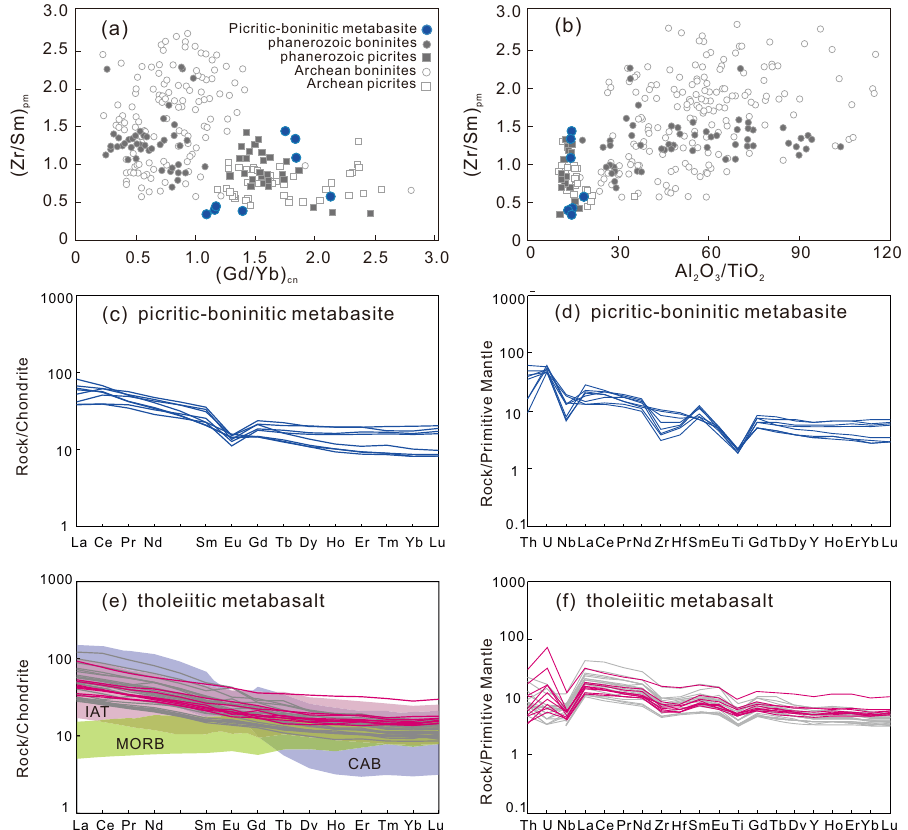
Fig. 7 Multi-element discriminant plots and variation diagrams of picritic-boninitic-tholeiitic series rocks. a , b Variation diagrams for a global dataset of Archean and Phanerozoic picrites and boninites 9 with our samples (blue) falling within the range for most elements and ratios. a Shows (Gd/Yb) cn vs. (Zr/ Sm) pm , b shows Al 2 O 3 /TiO 2 vs. (Zr/Sm) pm . c – f Chondrite- and primitive mantle-normalized diagrams for picritic-boninic and tholeiitic basalts. Normalization values from Sun and McDonough 60 . The gray lines represent reported IAT samples from the Zanhuang complex 26 ; the fi elds for MORB- IAT-CAB (Middle Oceanic Ridge Basalt-Island arc tholeiite basalt-Calc-alkaline arc basalt) data are collected from the (1) 2640 – 2522Ma MORB-IAT-CABs in the Fuxin terrane, western Liaoling 61,62 ; (2) 2657 – 2523 Ma MORB-IAT-CABs in the Shaqiaohe-Zhuzhangzi-Shangying terrane, Eastern Hebei 63 – 65 ;